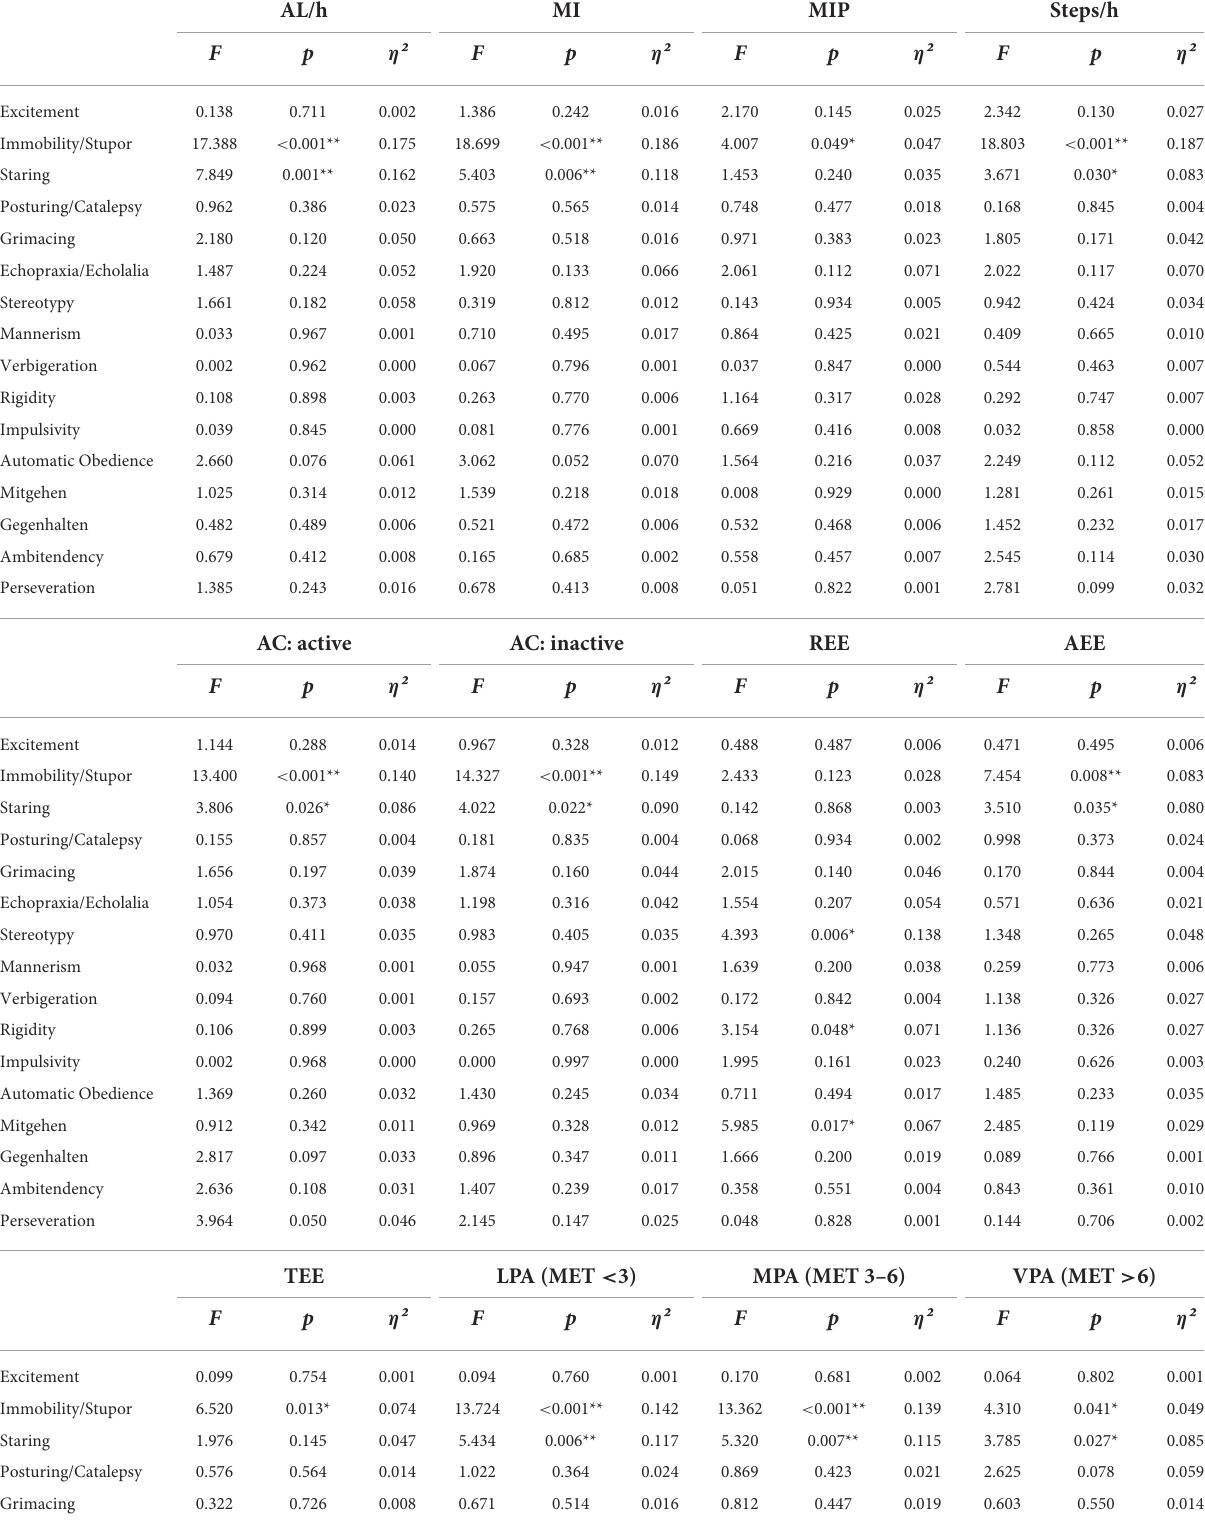
TABLE 4 Relationship between single BFCRS item ratings and physical or metabolic parameters controlling for age, medication (OLZ eq.), and body mass index